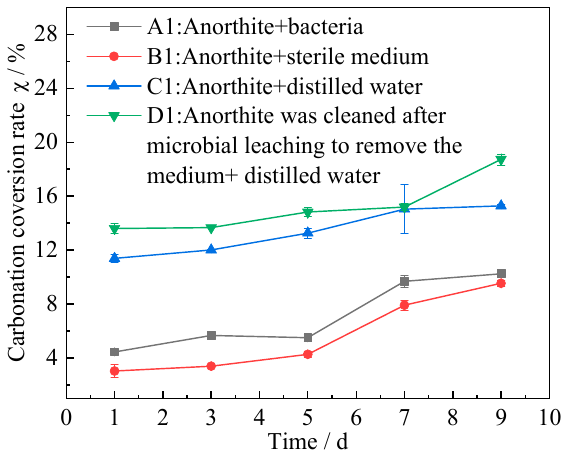
Figure 3. Ca 2+ concentration ( a ) during the leaching process and leaching rate ( b ) as a function of time.